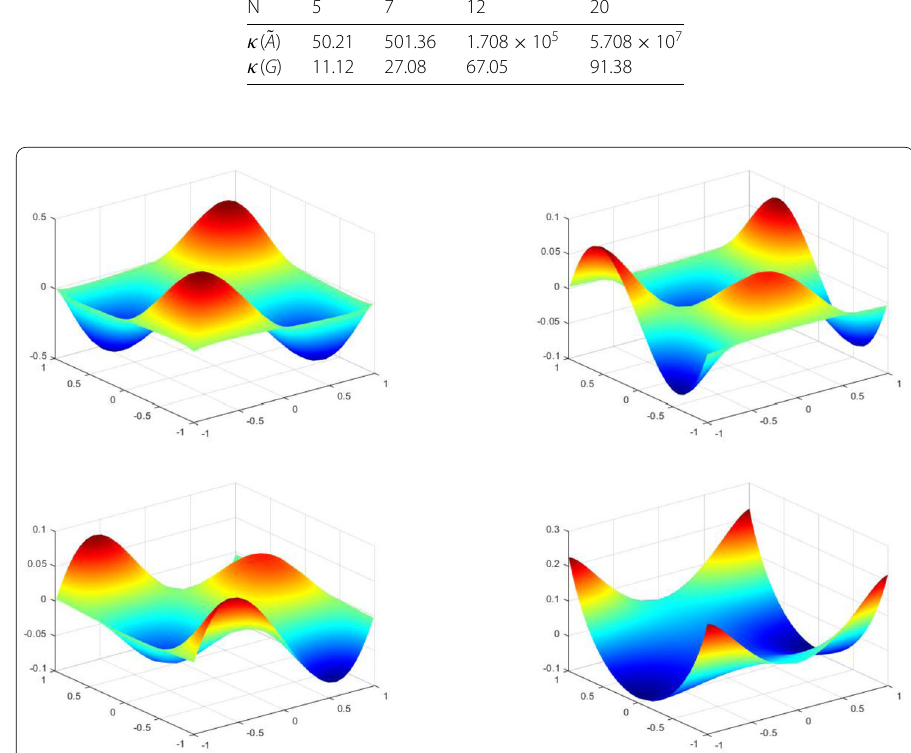
Figure 2 The discrete solution ( μ N , ϕ Nx , ϕ Ny , p N